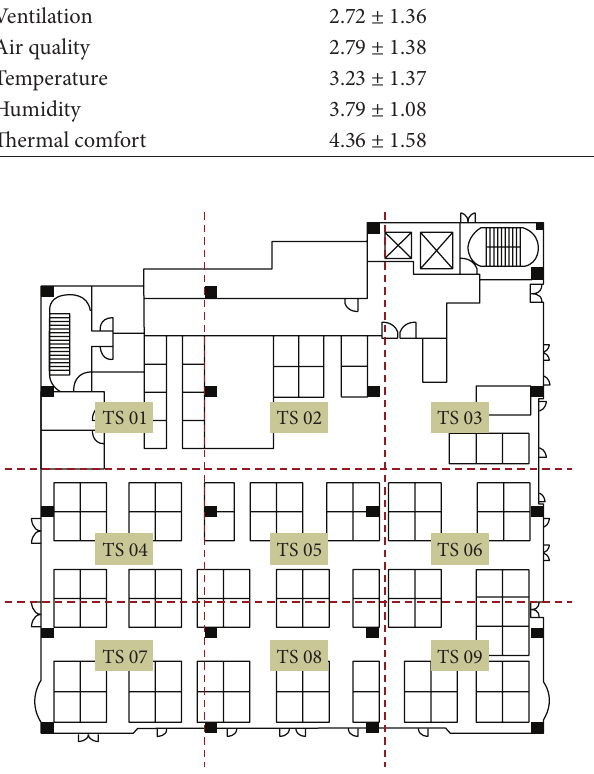
Figure 5: Nine sections for monitoring the distribution of CO 2 concentrations.